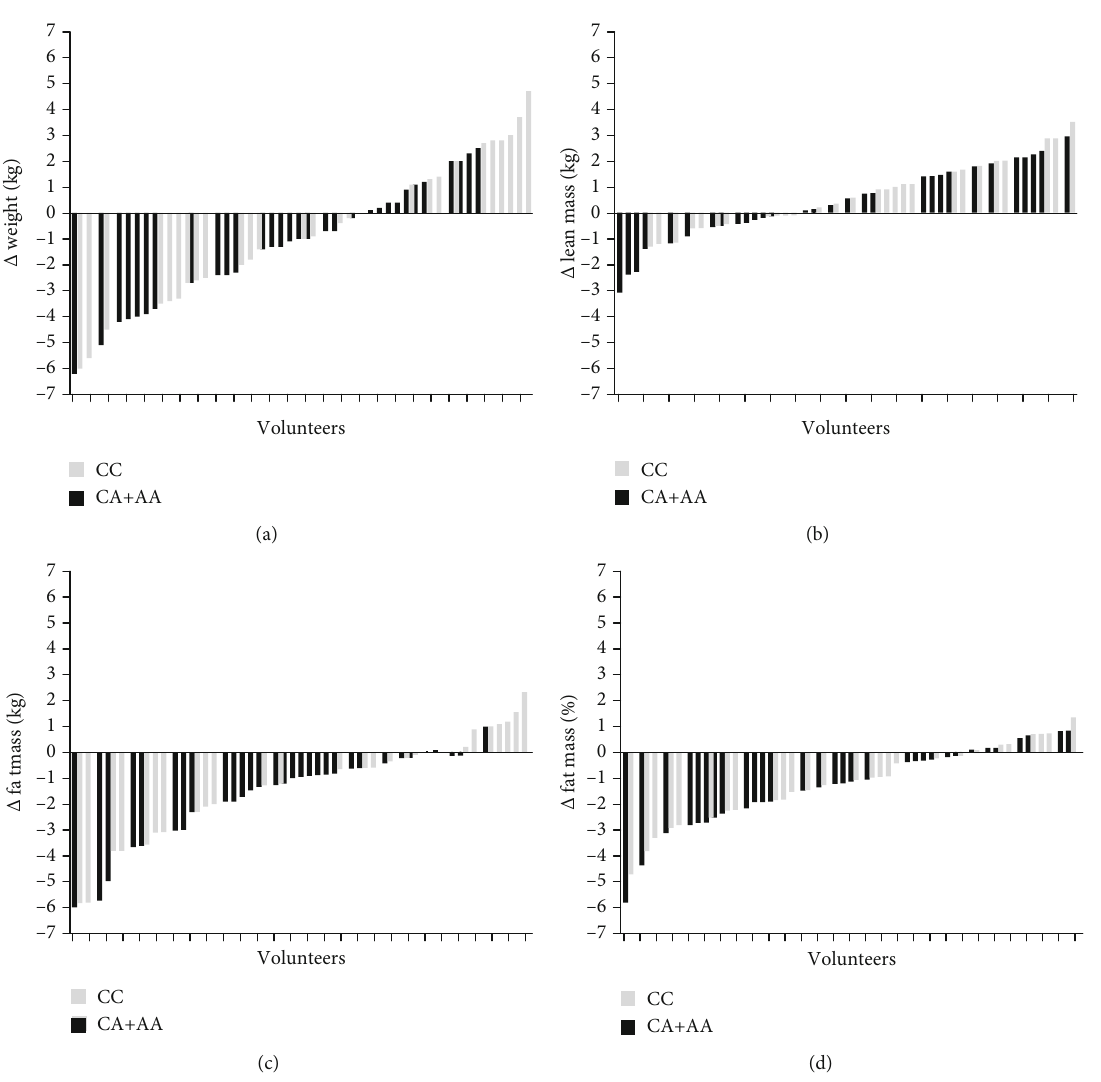
Figure 3: Interindividual di ff erence in the variation of the participants ’ body composition after intervention. Data are (a) weight, (b) lean mass, (c) fat mass, and (d) fat mass